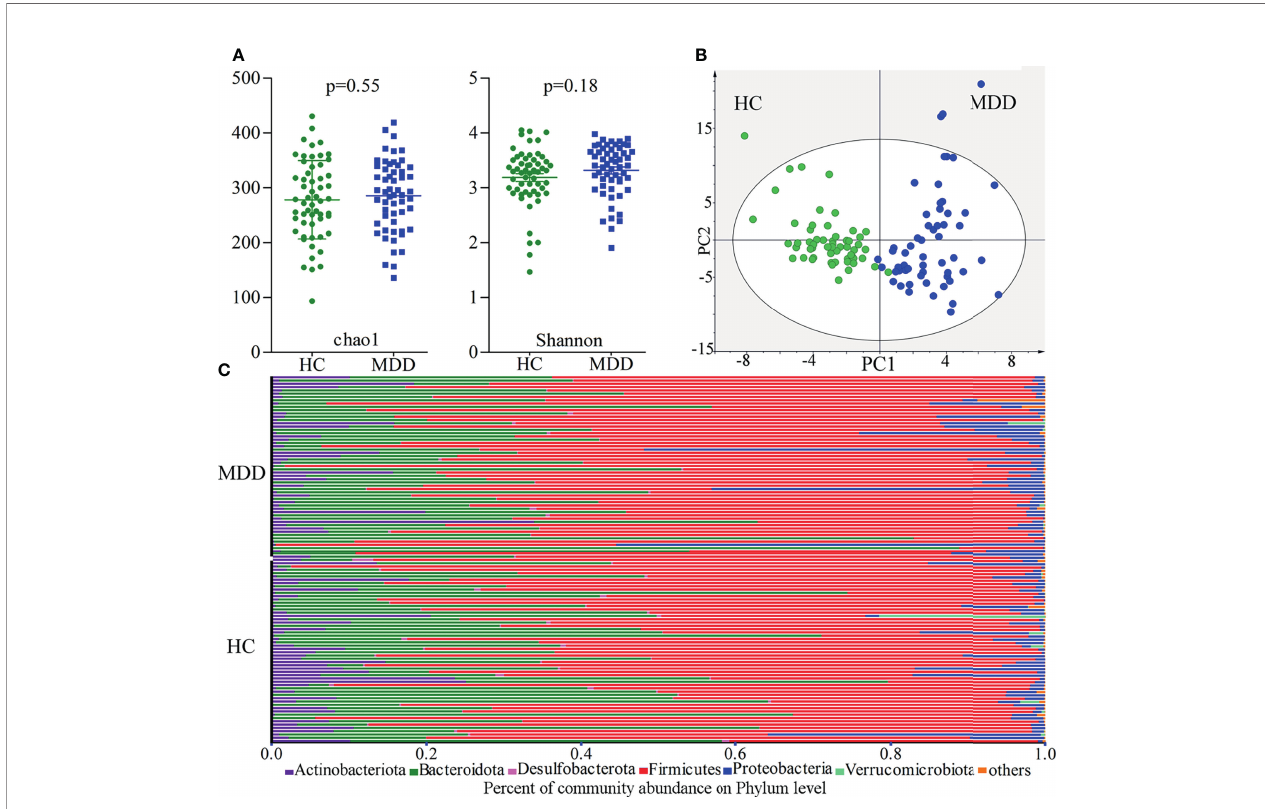
FIGURE 1 | Gut microbiota compositions in MDD patients and HCs. (A) No signi fi cant differences on within-sample ( a ) phylogenetic diversity between MDD patients and HCs were identi fi ed; (B) b -diversity analysis showed that there were signi fi cant differences on gut microbiota compositions between the two groups; (C) the relative abundances of gut microbiota at phylum level in both groups. MDD, major depressive disorder; HCs, healthy